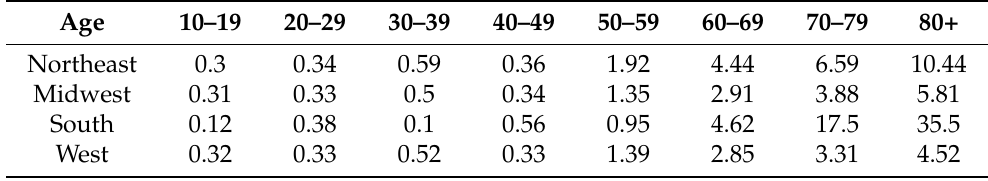
Table 10. Neural network-estimated probabilities of death for a hispanic male with no pre-existing conditions by region and age group. Given as